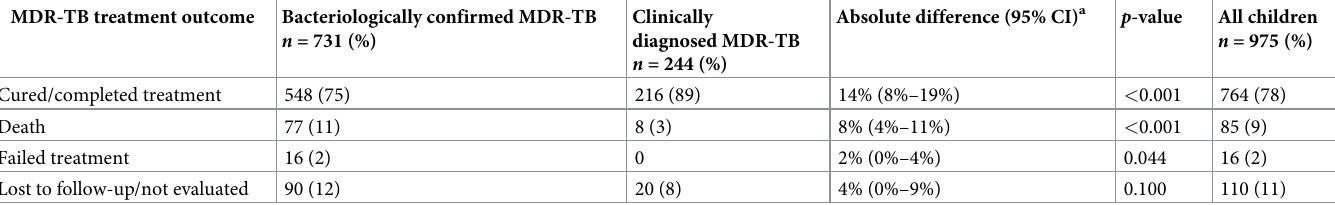
Table 3. Summary of treatment outcomes for children treated for MDR-TB.